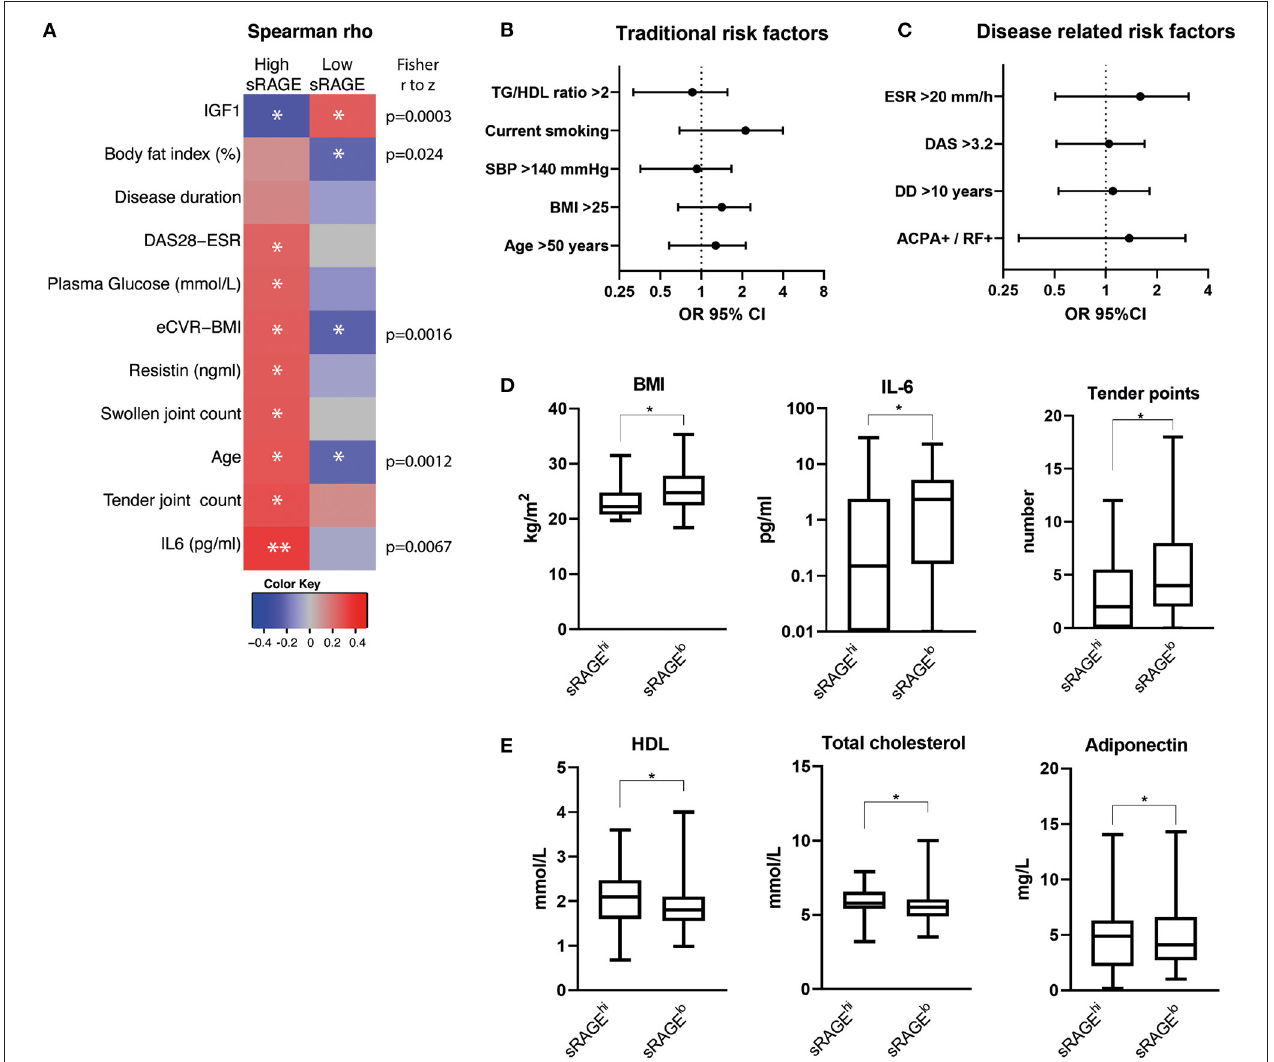
FIGURE 2 | Correlation between sRAGE levels and cardio-metabolic and inflammatory parameters within respective groups (A) and the differences in frequency of the traditional cardiovascular risk factors (B) and RA-related risk factors (C) between the patients with high ( n = 73) and low ( n = 98) serum levels of soluble RAGE. Correlation matrix in (A) shows Spearman’s R -values in color as indicated by color key code. * P < 0.05; ** P < 0.01. The differences as indicated by forest plots in (B,C) are calculated as odds ratio (OR) with 95% confidence interval (CI). The p -values are obtained by chi-square statistics. Comparison of the traditional, inflammation- and RA-related CVR factors for ages < 50 years ( n = 66) (D) , and ≥ 50 years ( n = 105) (E) , in sRAGE lo and sRAGE hi group. The comparison is done pairwise using the Mann-Whitney U -test. The box plots indicate medians and interquartile ranges; whiskers show min to max. * P < 0.05; ** P < 0.01. BMI, body mass index; DAS28, disease activity score with assessment of 28 joints; eCVR, estimated cardiovascular risk; IL, interleukin; RAGE, receptor for advanced glycation end products; HDL, high density lipoprotein. TG/HDL, ratio between triglycerides and high-density lipoprotein; TC, total cholesterol; ESR, erythrocyte sedimentation